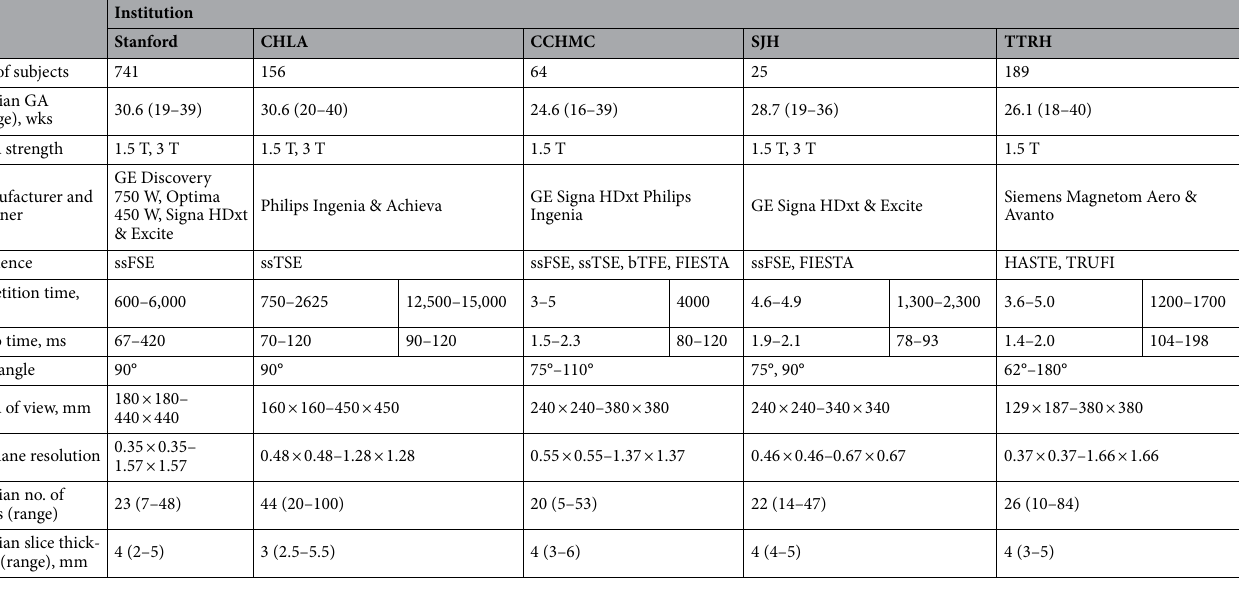
Table 3. MRI datasets and acquisition parameters by institution. ssFSE single-shot fast spin-echo, ssTSE single-shot turbo spin-echo, bTFE balanced turbo field echo, FIESTA fast imaging employing steady